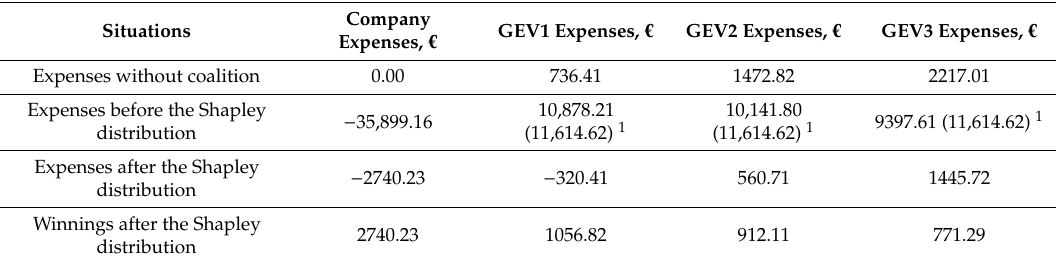
Table 4. Annual charge / discharge expenses of the coalition participants (players), applying the new billing